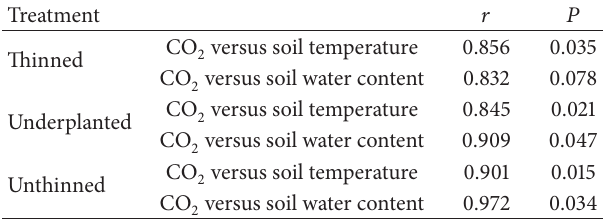
Table 4: Correlation analysis between soil respiration and soil temperature or soil water content at the temporal